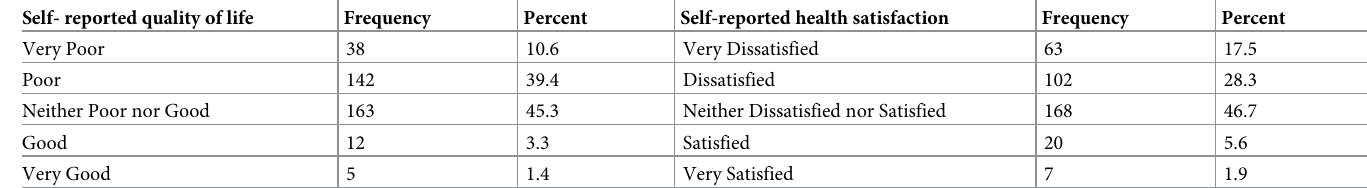
Table 4. Health status satisfaction and self-rating of health related quality of life of hypertension patients on treatment attending public health facilities in Dessie City Administration, Dessie, Northeast Ethiopia 2021.